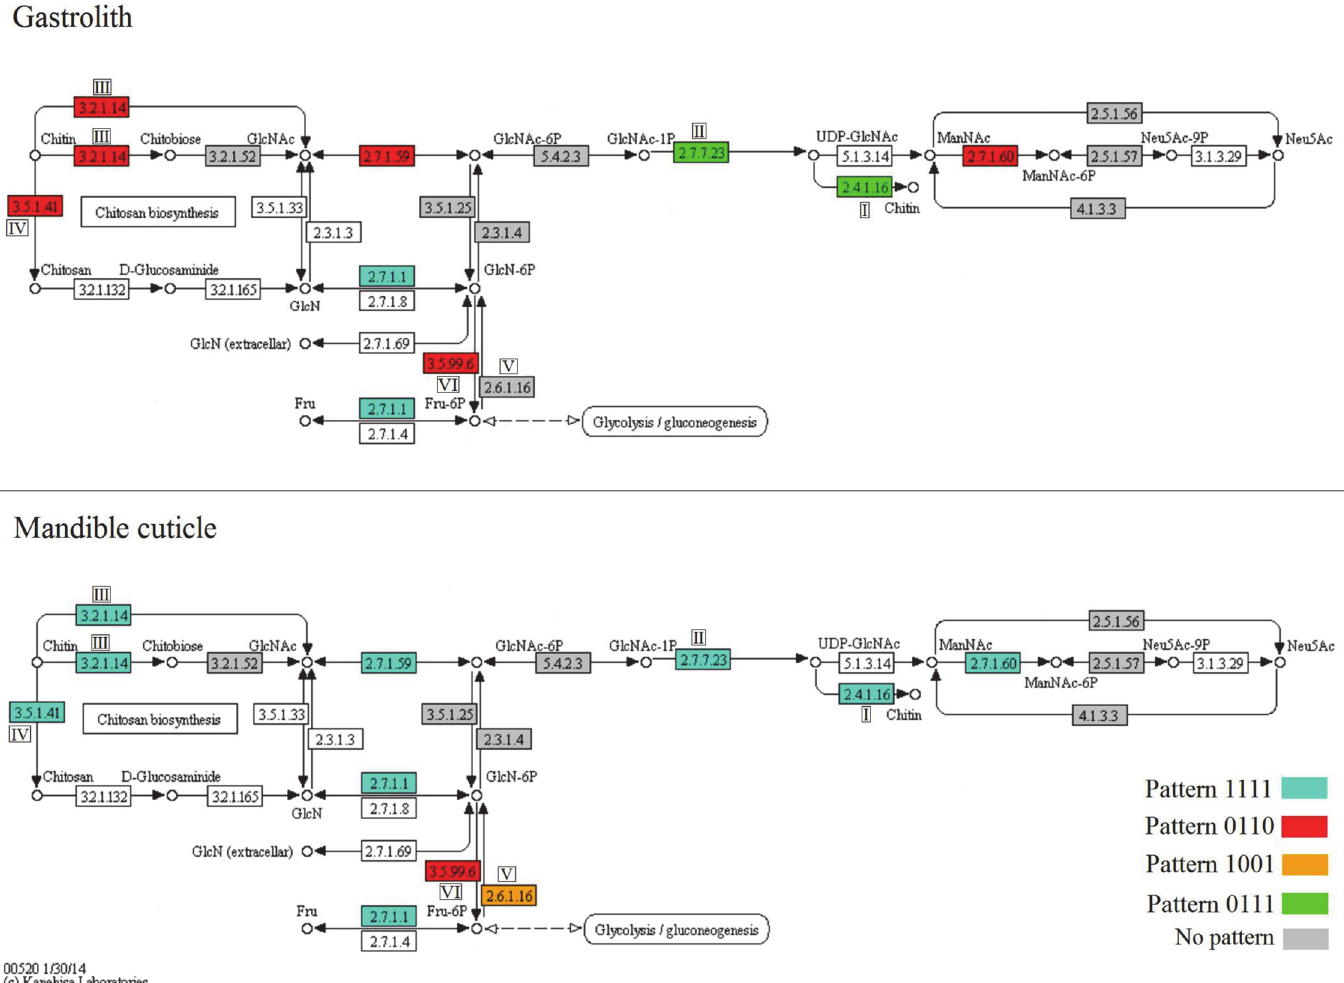
Fig 4. Duplicates of the amino sugar metabolism pathway, modified from KEGG. The upper panel shows gene expression patterns in the gastrolith- forming epithelium, while the lower panel shows gene expression patterns in the mandible cuticle-forming epithelium. Enzymes that were found in the transcriptomic library are highlighted in blue for pattern 1111, red for pattern 0110, orange for pattern 1001, green for pattern 0111 and grey for enzymes that did not show any pattern. Enzymes discussed in the text are marked as I for chitin synthase, II for uridylyltransferase, III for chitinase, IV for chitin deacetylase, V for GlcN-6P synthase and VI for GlcN-6P